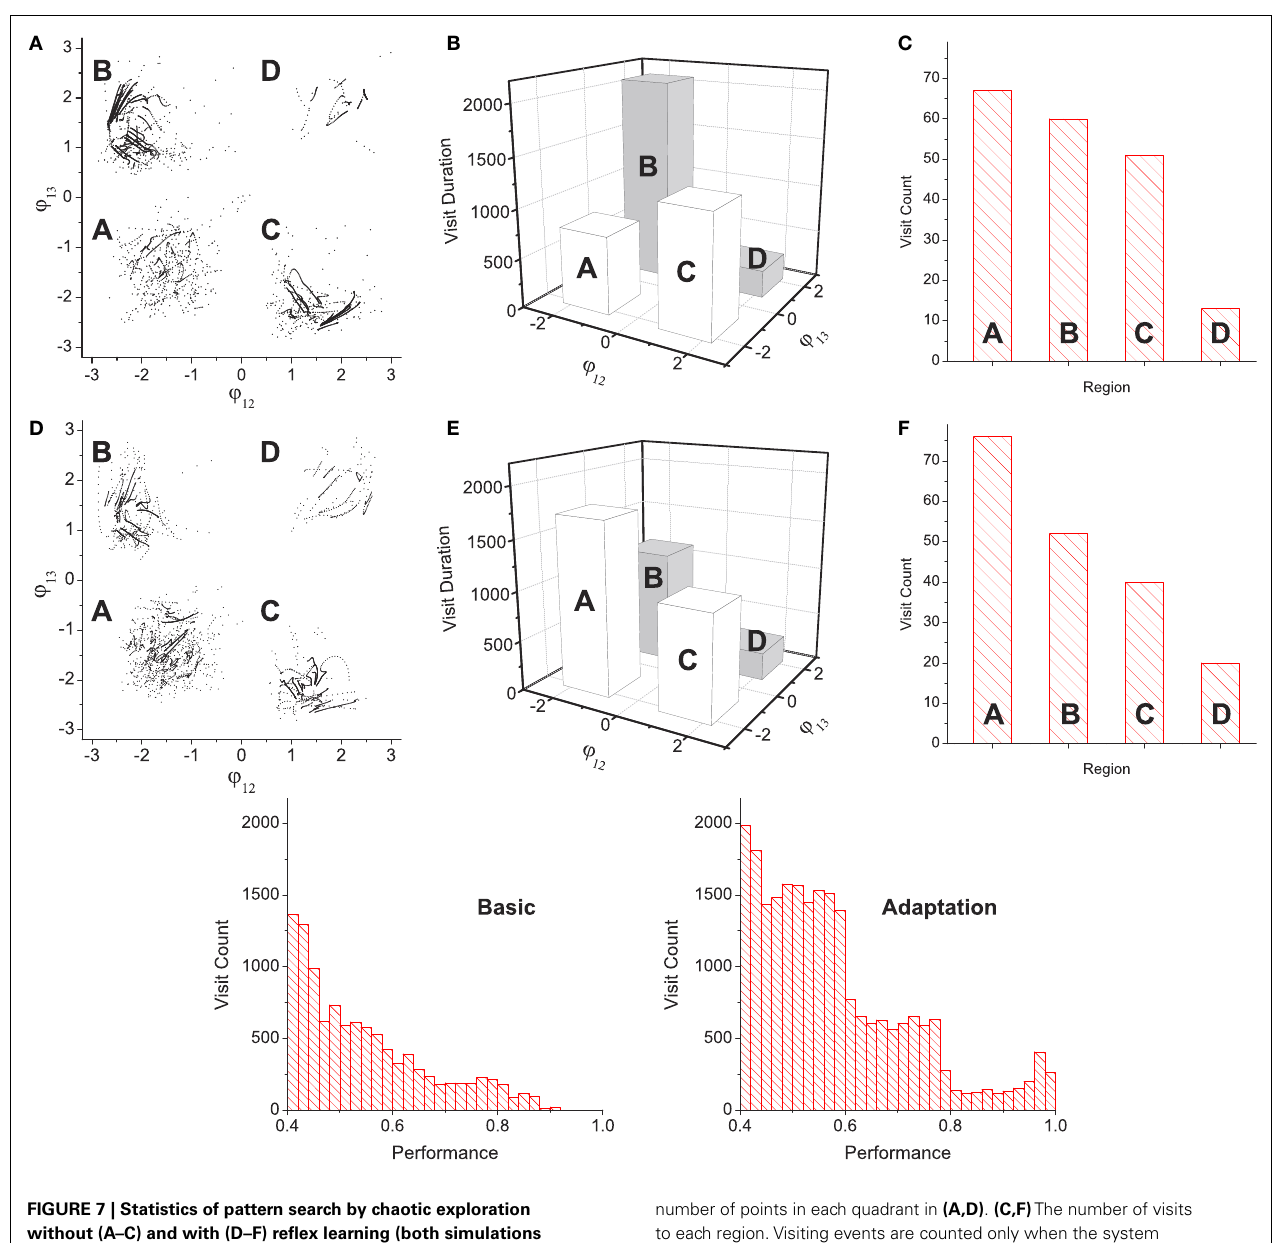
FIGURE 7 | Statistics of pattern search by chaotic exploration without (A–C) and with (D–F) reflex learning (both simulations are run for 12,000 CPG periods) . (A,D) Visited points are plotted on the phase space whenever the system is in the stable regime (i.e., when the global bifurcation parameter is µ< 0.001). (B,E) Total visit durations near each pattern in units of CPG revolution, i.e., the